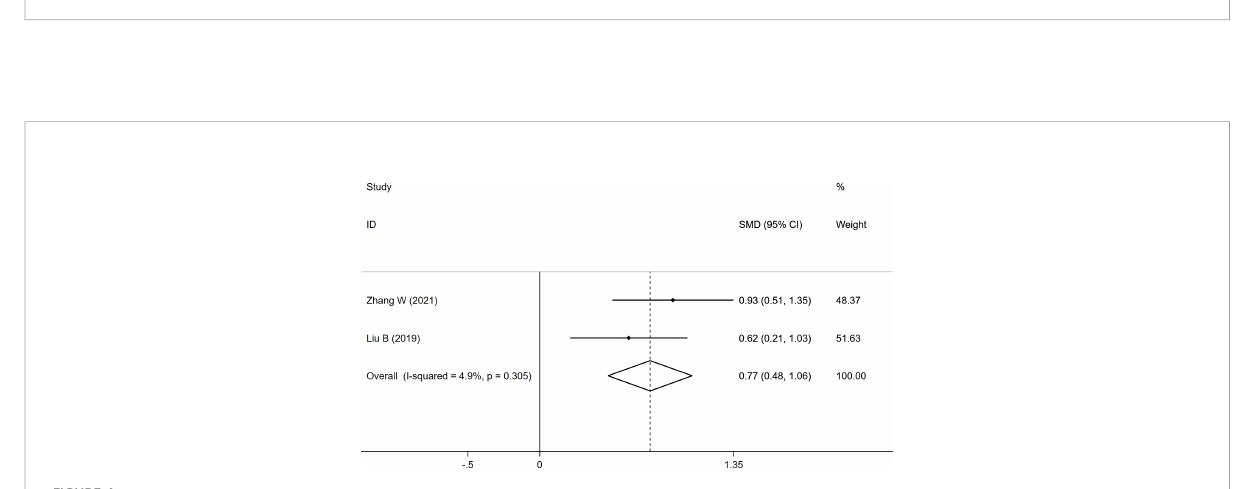
FIGURE 4 Forest plot of the FI comparing the fracture group with the non-fracture group.